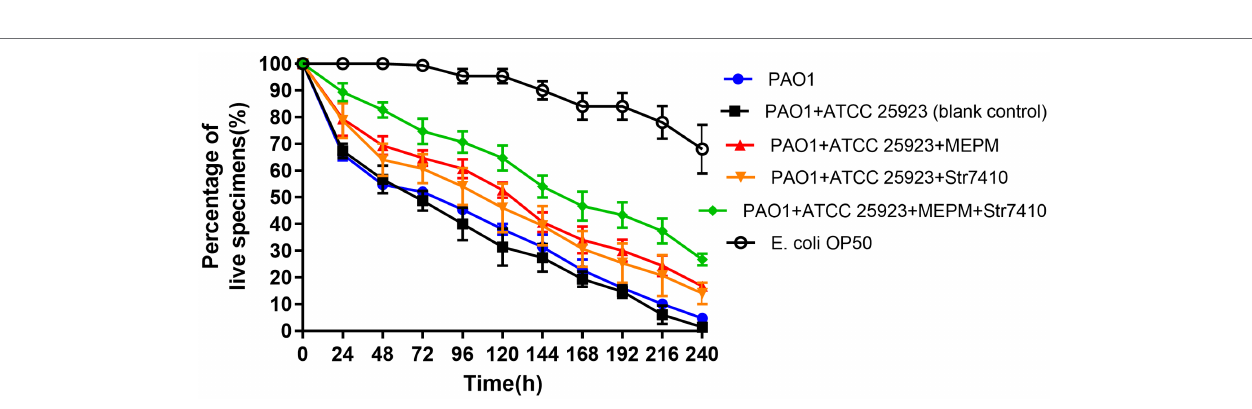
FIGURE 4 | Effect of treatment with compound Str7410 (40 μ M) and the antibiotic MEPM (0.5 μ g/ml) alone or combination on survival of Caenorhabditis elegans N2 co-infected with Pseudomonas aeruginosa PAO1 and Staphylococcus aureus ATCC 25923. Escherichia coli OP50 was used as a negative control. Values are presented as the mean ± SD ( n =